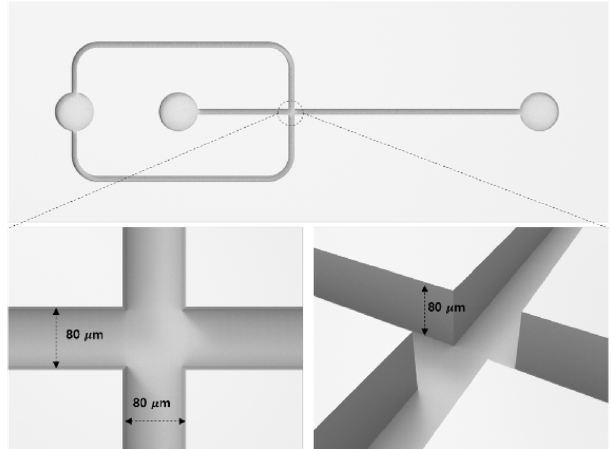
Figure 6. Illustration of the microfluidic chip employed to prepare the